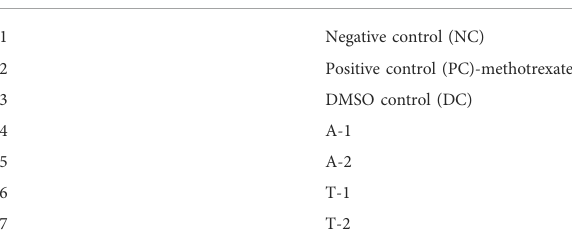
TABLE 1 Standard and tested compounds used in the